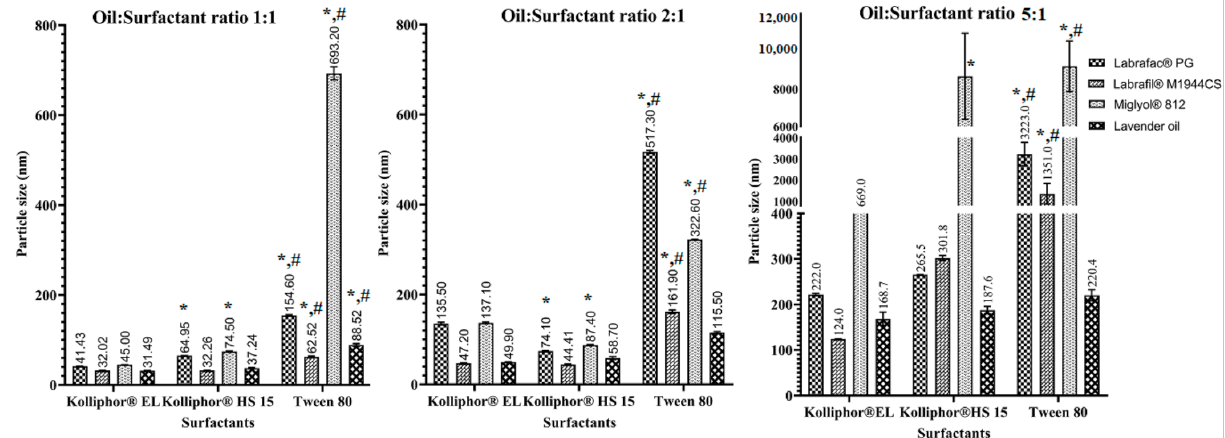
Figure 2. The effect of surfactant type and oil:surfactant ratio on the particle size of LNCs. All values are presented as the mean ± SD ( n = 3). * Significant difference in comparison to Kolliphor ® EL. # Significant difference in comparison to Kolliphor ®